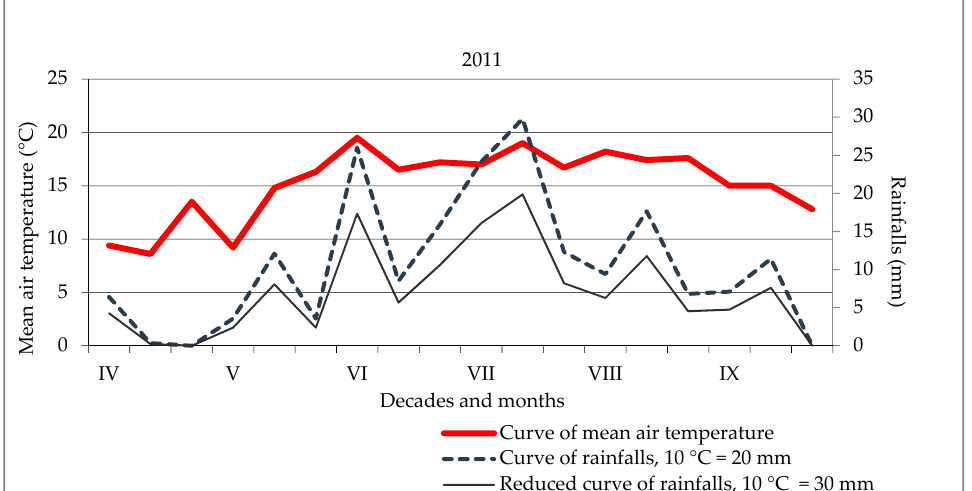
Figure 1. Climatic diagram for meteorological conditions from April to September (IV–IX) in